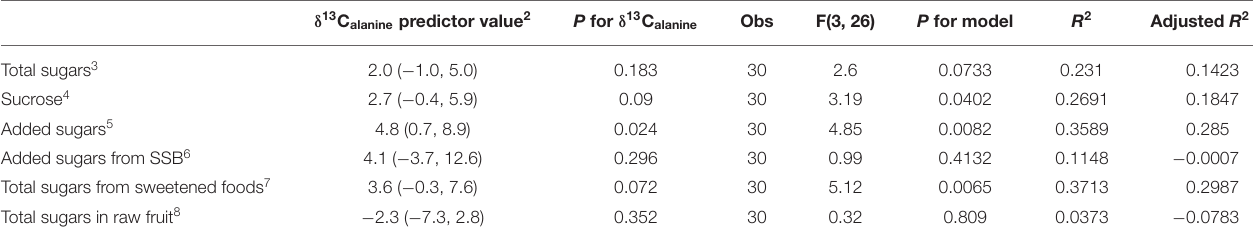
TABLE 5 | Associations between dietary sugars intakes (g/d) and δ 13 C alanine from a multivariate log linear regression model 1 .